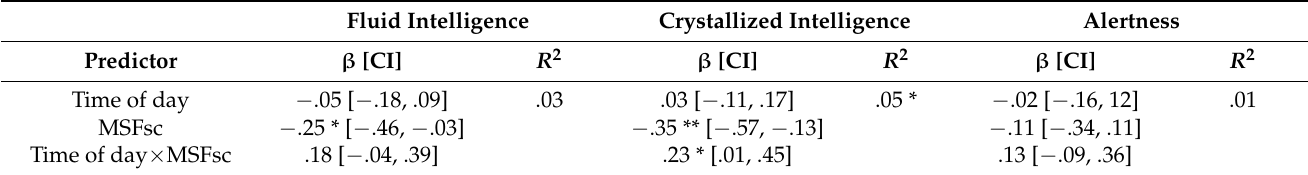
Figure 1. Association between chronotype (MSFsc—mid-sleep on free days, sleep-corrected) and performance on the test measuring crystallized intelligence during a morning versus an afternoon class. Table 3. Results of linear regressions with two types of intelligence and alertness as outcomes.